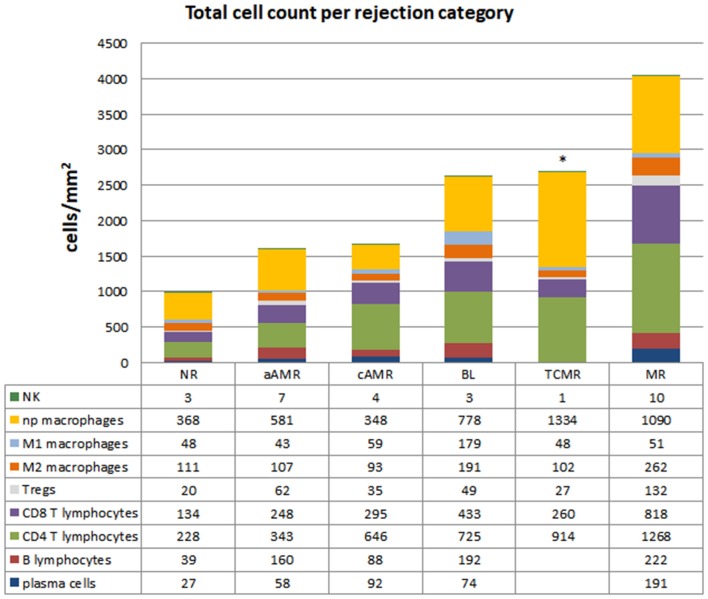
Total cell counts in diagnostic biopsies of rejection. Cell quantification of the inflammatory infiltrates showing cell type composition. The numbers for each cell type represent the mean values obtained from a group of patients within each rejection category. CD20+ B lymphocytes, CD138+ plasma cells, CD4+ T lymphocytes, CD8+ T lymphocytes, T regulatory cells FoxP3+, CD68+ (distributed as non-polarized, M1 and M2), and CD56+ natural killer cells were assessed. *The data for B lymphocytes and plasma cells are missing in the TCMR group due to the low number of tissue samples. The mean numbers of each cell type/mm2 tissue are shown below each group.